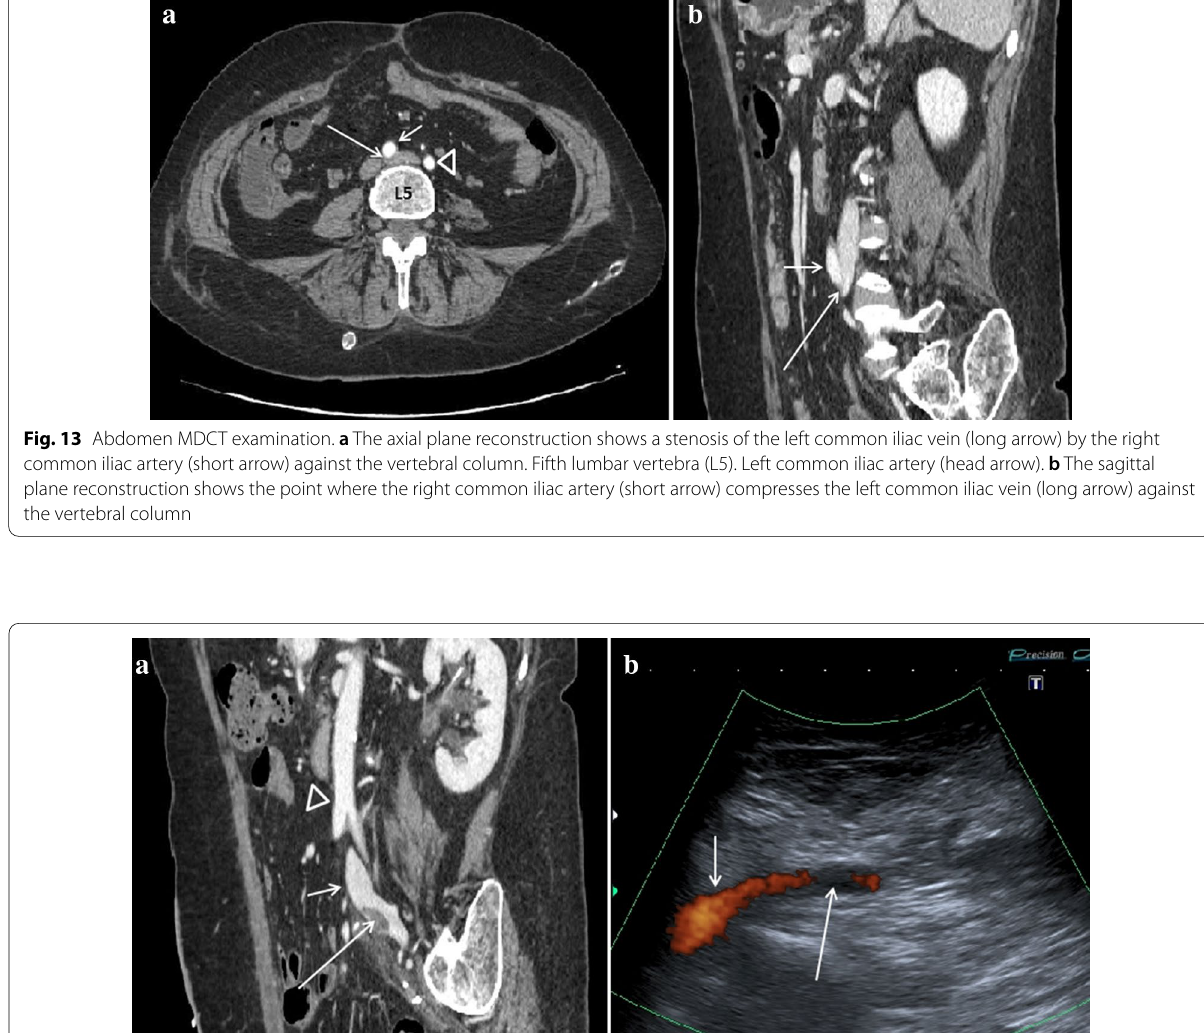
is significant, the resulting chronic ischemia becomes symptomatic and can change with the respiratory acts; in fact, it generally increases with forced exhala- tion which causes a relaxation in the diaphragm and a